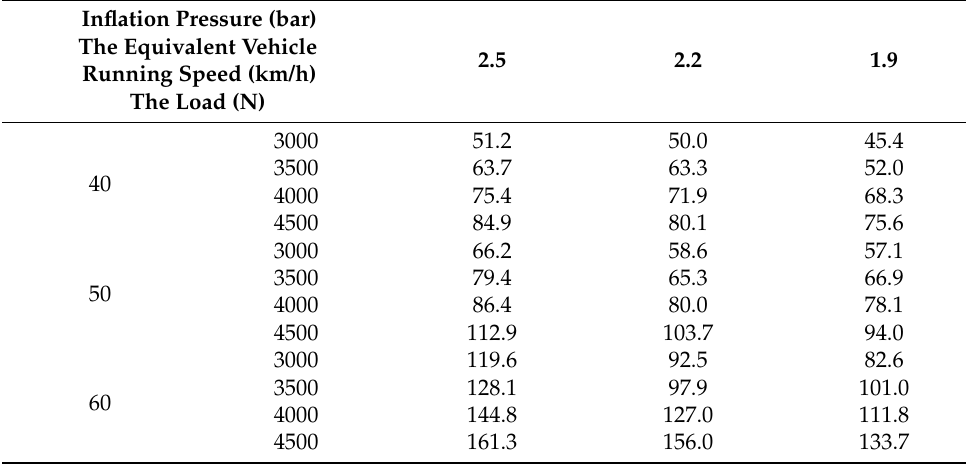
Table 3. Maximum acoustic pressure amplitudes (Pa).